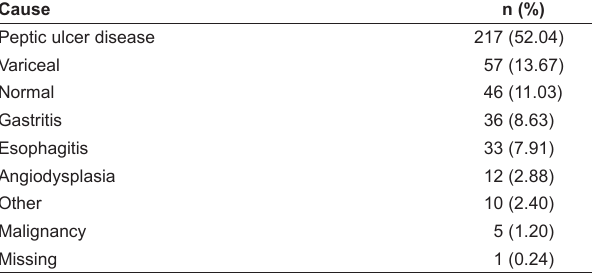
TaBle 3 Causes of gastrointestinal bleed (n=417) Cause Peptic ulcer disease